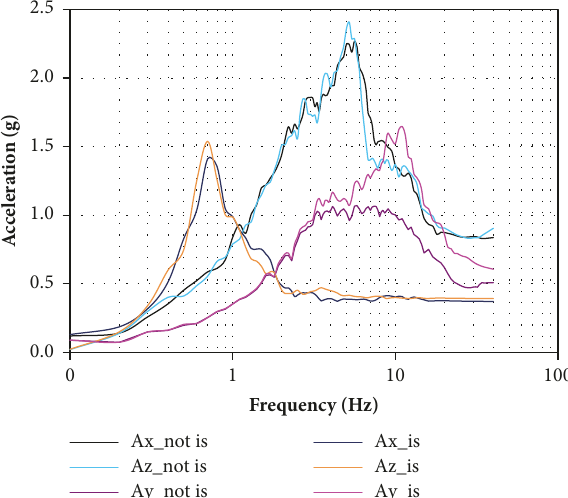
Figure 10: Response spectra comparison.